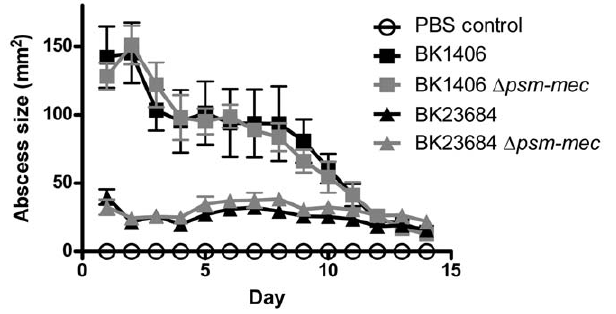
Figure 4. Mouse abscess model. Isogenic psm-mec deletion mutants of strains BK1406 (SCC mec type III) and BK23684 (SCC mec type VIII) were compared to their corresponding wild-type strains in a mouse abscess model that was performed as previously described for strain MSA890 and its psm-mec deletion mutant [9]. Abscesses formed by strain BK1406 usually presented with open lesions, whereas those formed by strain BK23684 did not. There were no significant differences (using t-tests) between corresponding wild-type and psm-mec deletion mutant strain abscess sizes.